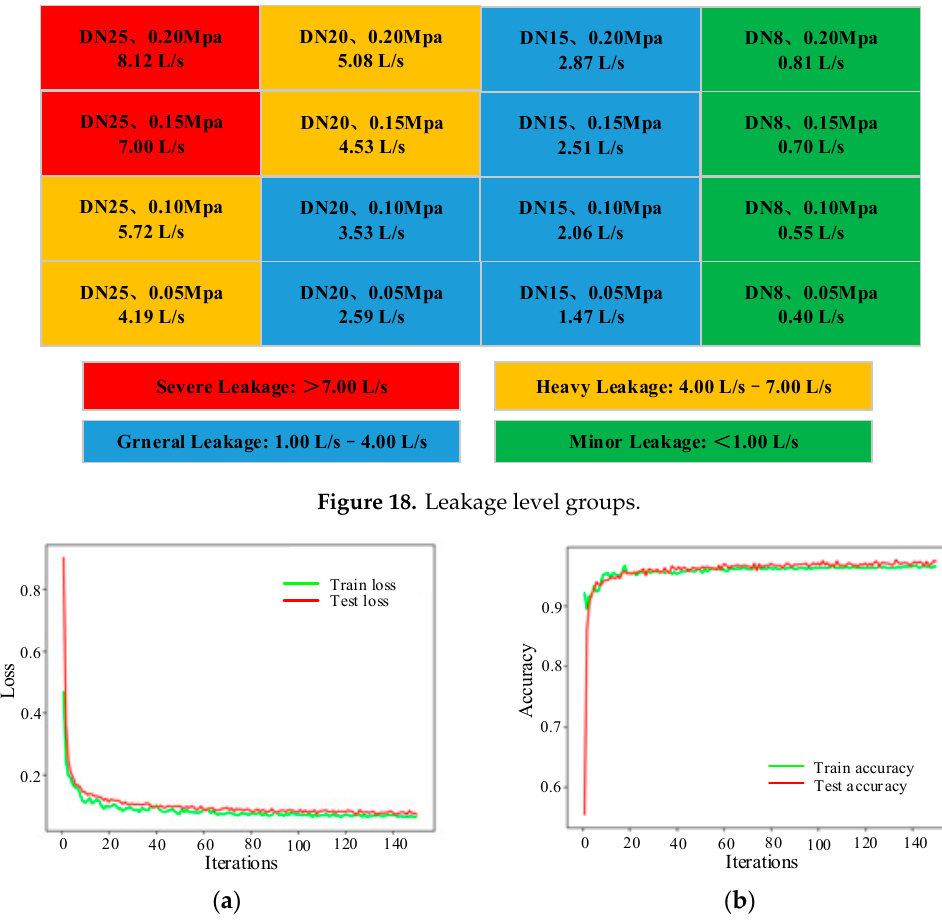
Figure 19. Leakage level identification. (a) Identification loss; (b) Identification accuracy